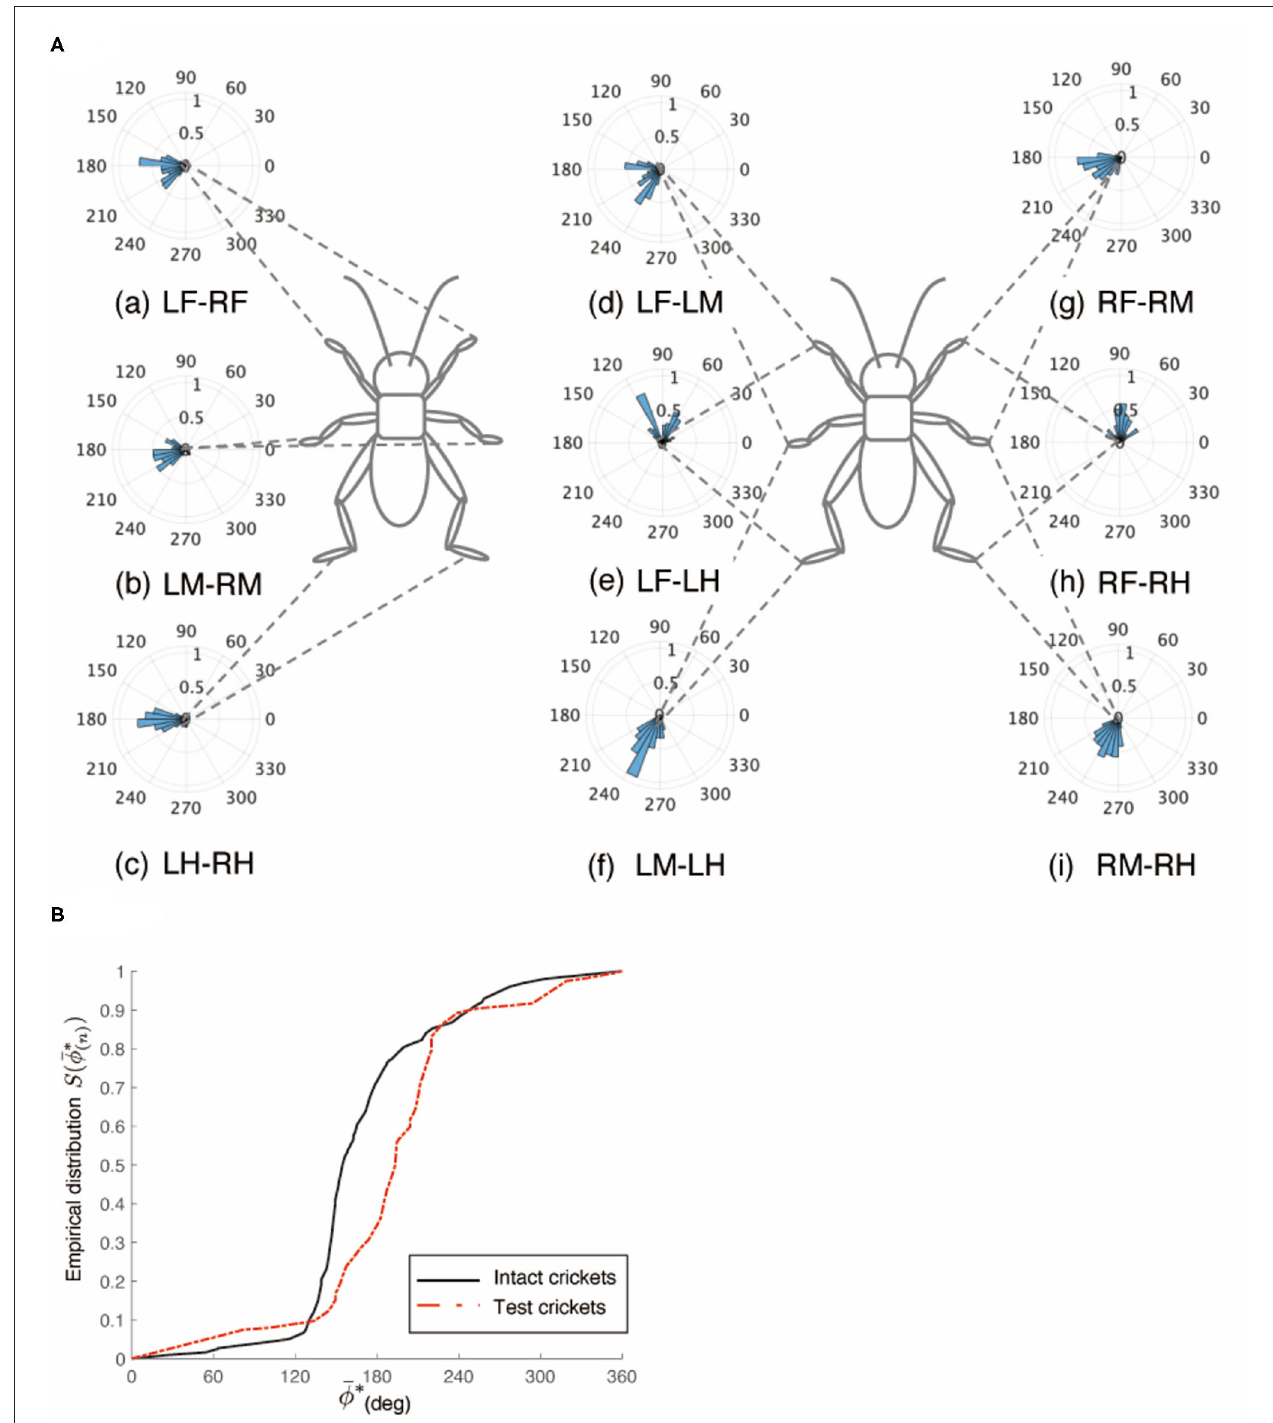
FIGURE 2 | Walking gait pattern of crickets in which paired nerve connectives between brain and SEG were cut. (A) Polar histograms indicate phase differences between two legs in test crickets ( N = 5). The polar histograms demonstrate that the test crickets exhibited a tripod gait pattern on the floating ball of the treadmill. (a–i) Phase differences between pairs of legs. (B) Comparison of the empirical distribution function of leg phase differences between left and right legs Φ LM − RM The black line indicates the empirical distribution function of the intact crickets and the red line indicates that of the crickets in which the pair of connectives between the brain and SEG was cut. LF, left foreleg; RF, right foreleg; LM, left midleg; RM, right midleg; LH, left hind leg; RH, right hind leg.